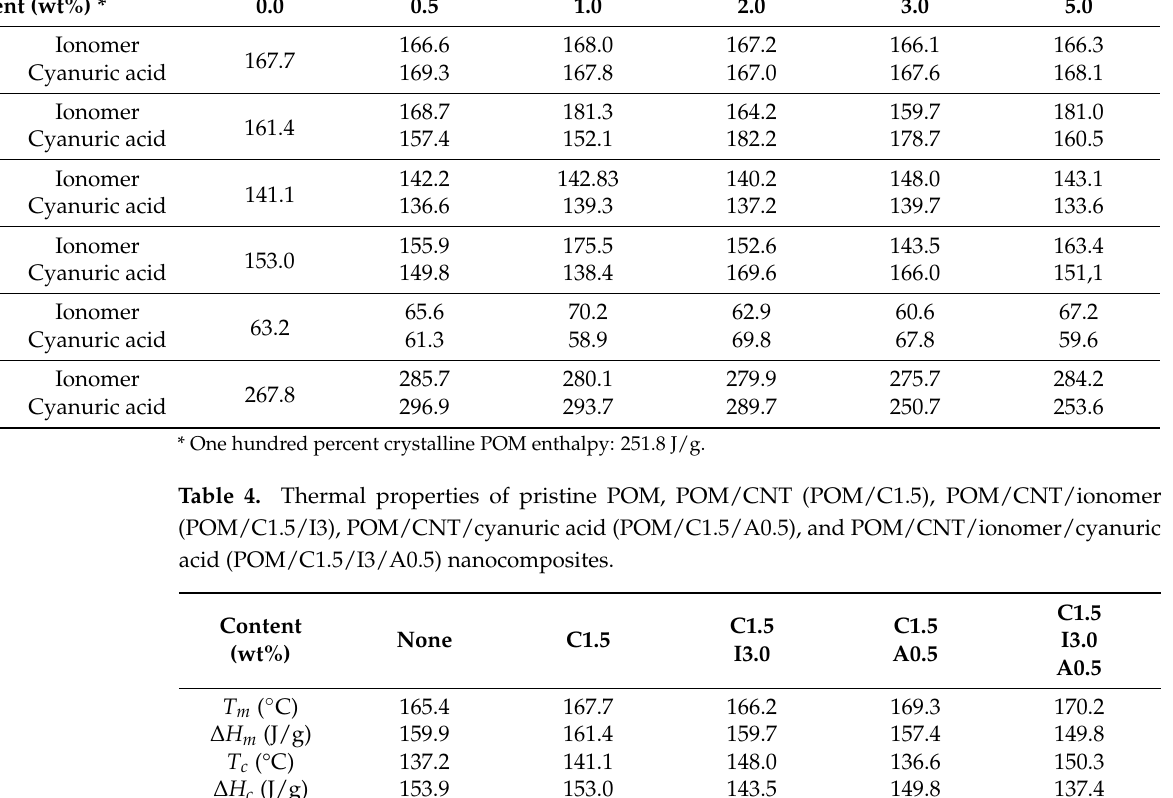
Table 3. Thermal properties of POM/C1.5, POM/C1.5/ionomer, and POM/C1.5/cyanuric acid composites as a function of additive concentration.